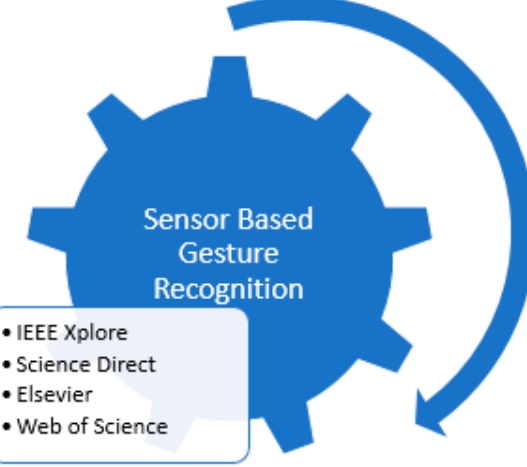
Figure 15. Databases used for Sign language recognition-based articles.